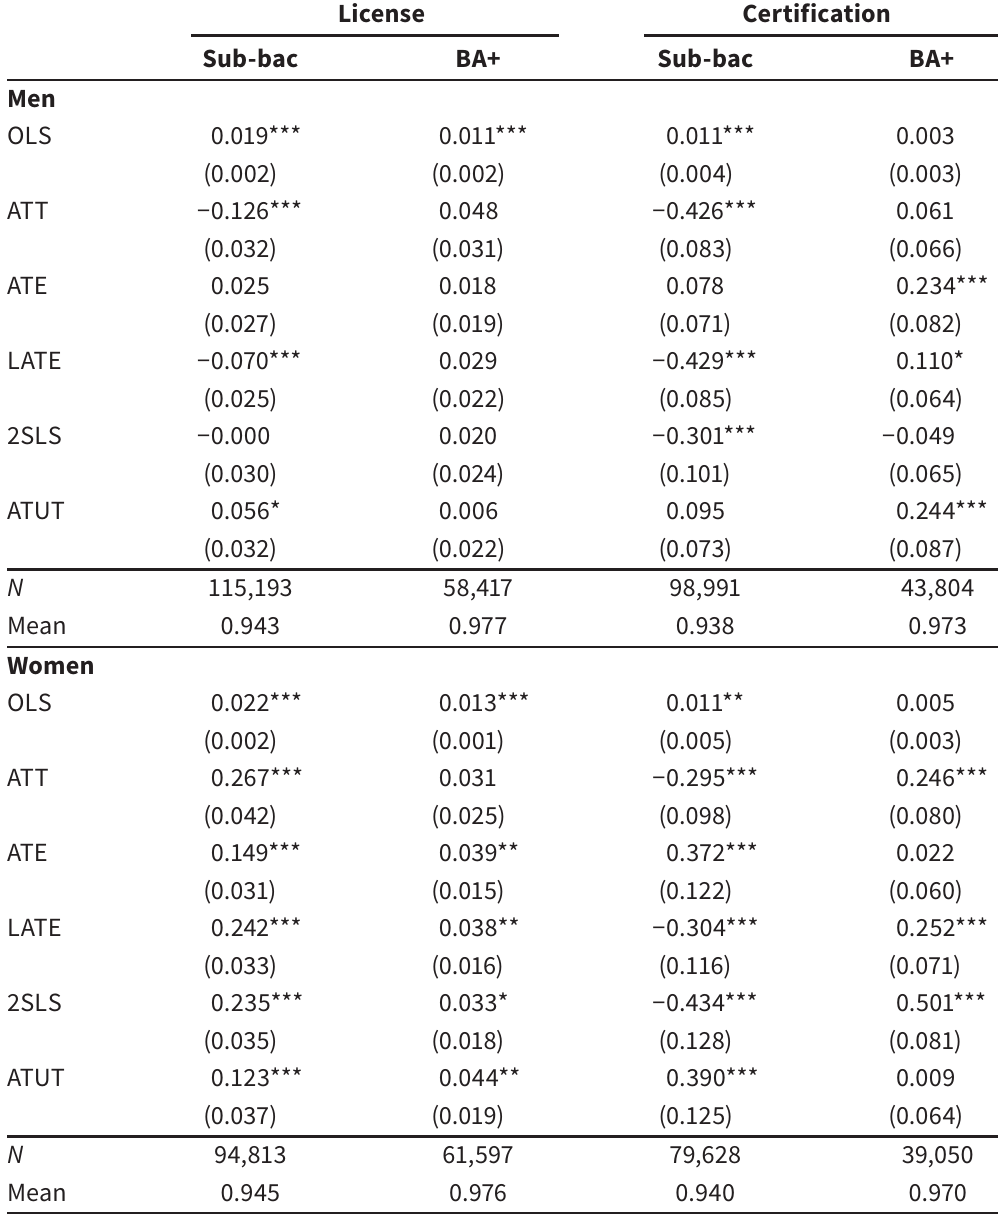
Table A4 Effects of credential-holding on employment by gender and level of education License